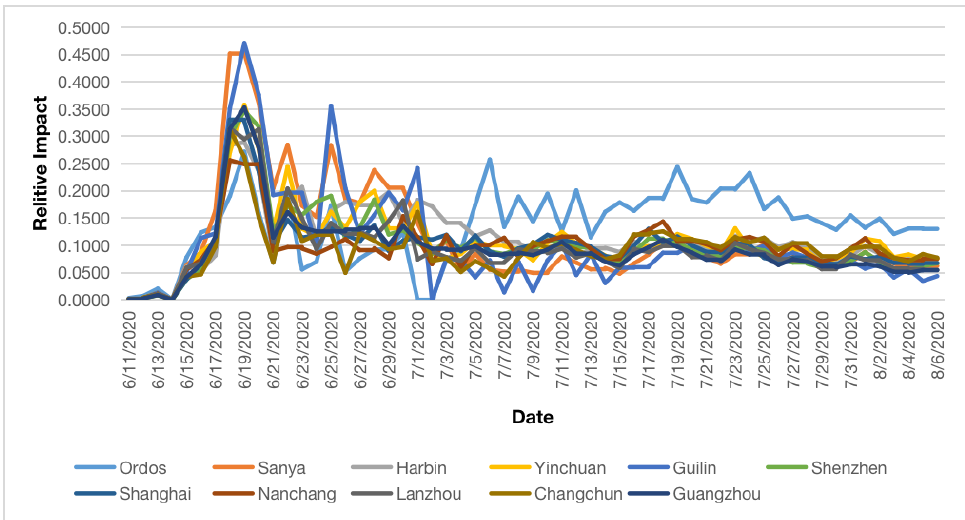
Figure 11. The impact of outbreaks in Beijing on air routes.